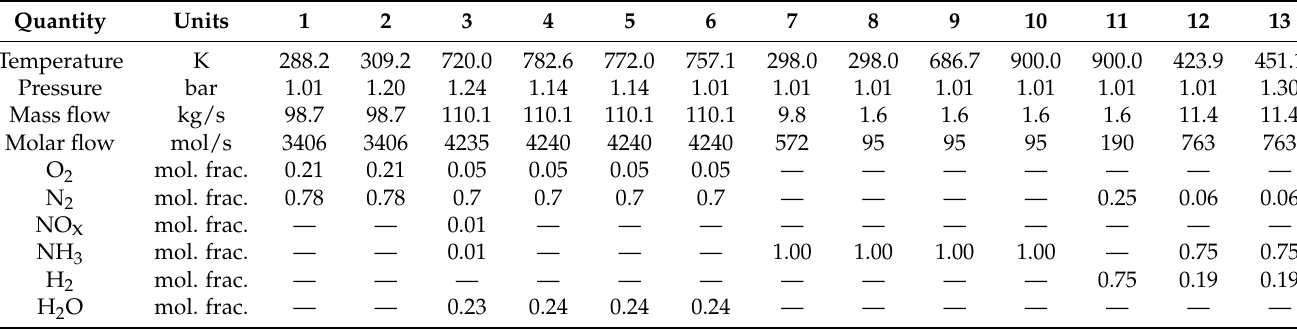
Figure 13. The process flow diagrams of an ammonia-fuelled ICE powertrain ( left ) and GT powertrain ( right ). Table 9. The state points corresponding to the process flow diagram given by Figure 13 for an ICE 78 MW New Panamax vessel at maximum continuous rating